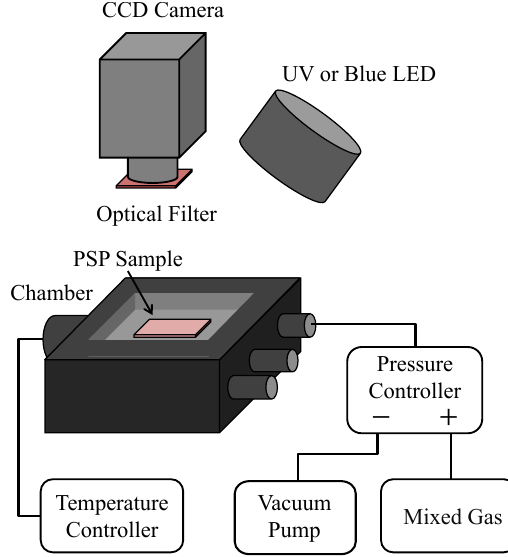
Figure 2. Schematic diagram of the calibration chamber. Table 3. Composition of cylinder gas for various oxygen mole